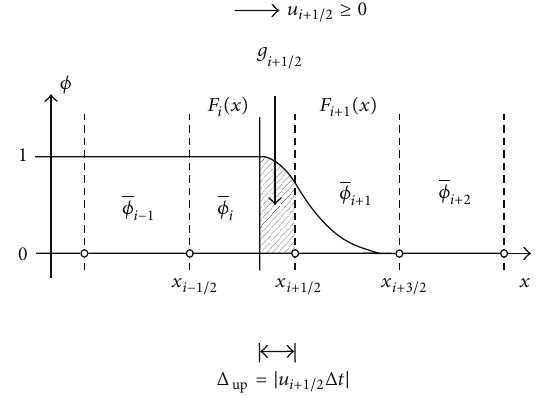
Figure 1: Concept of the THINC scheme.